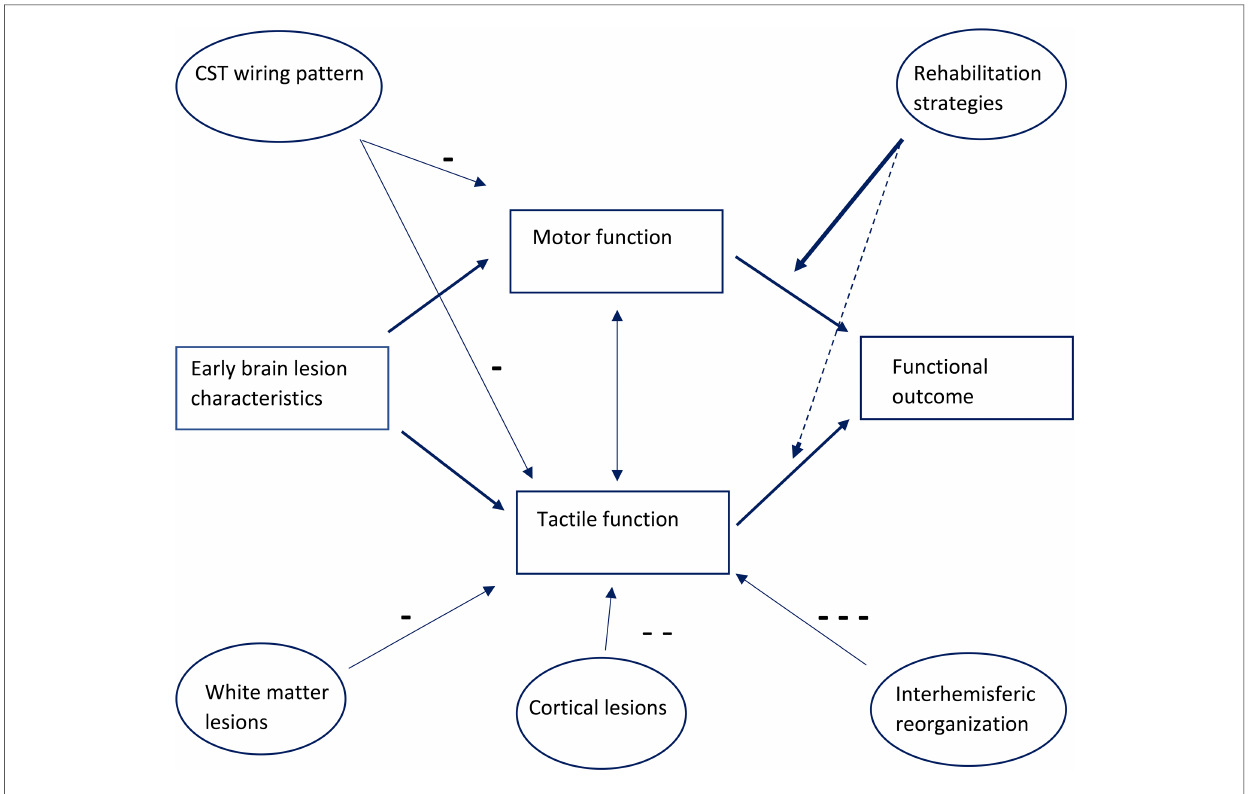
FIGURE 2 Diagram lesion relating to tactile, motor function and functional outcome, in fl uencing anatomical lesions, rehabilitation strategies so far focused mostly on improvement of motor